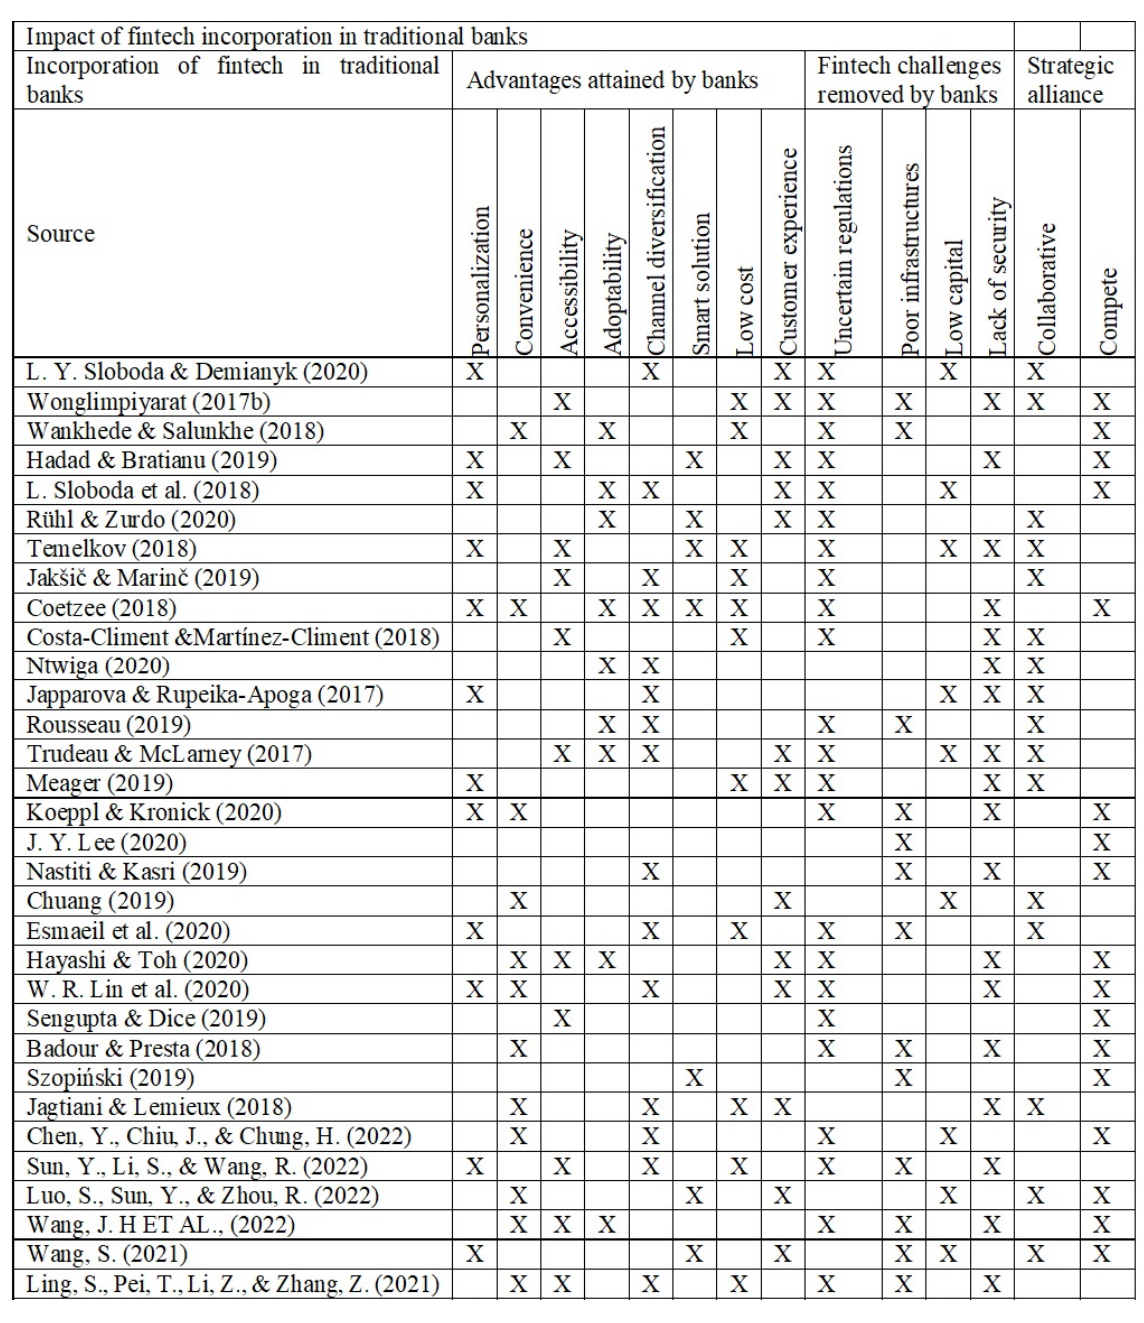
Figure 3. Impact of Fintech incorporation in traditional banks. Source: Researchers’ own source.